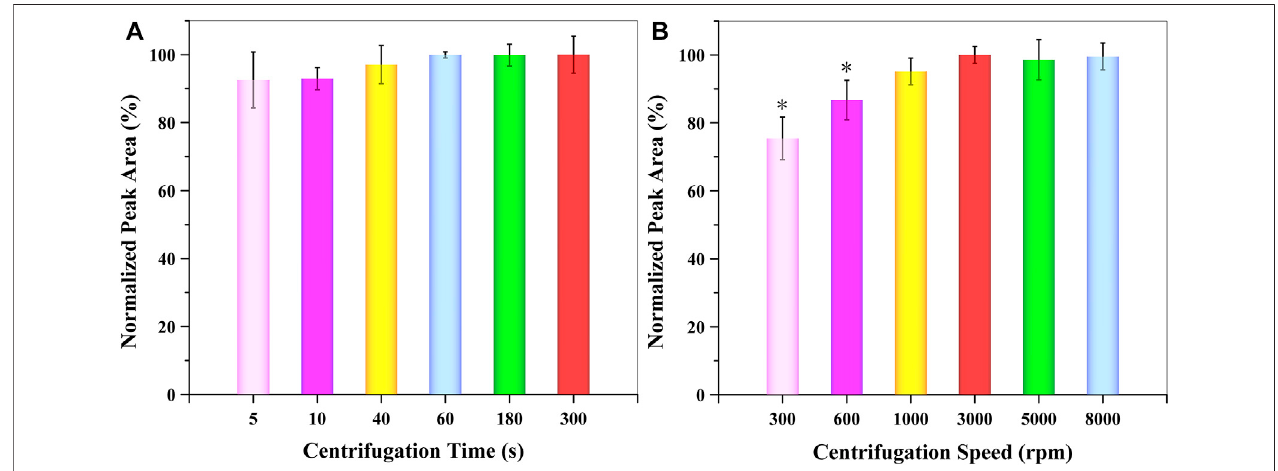
FIGURE 6 | Effect of (A) centrifugation time and (B) speed on extraction ef fi ciency ( n (cid:2) 3; * p < 0.05).